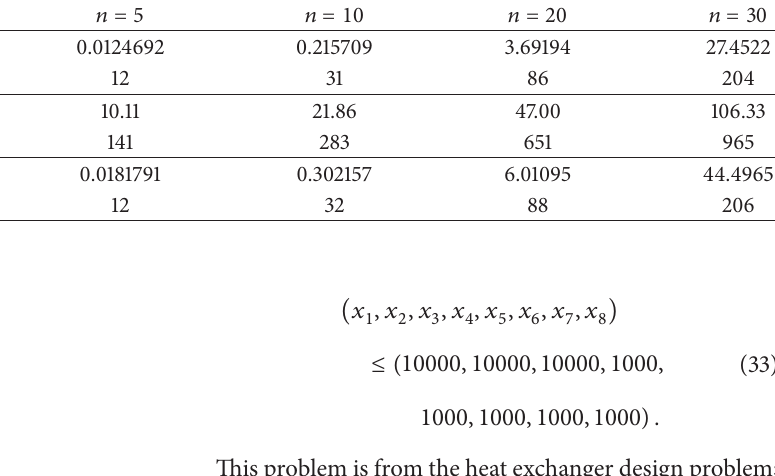
Table 3: Numerical comparisons with Refs. [16, 21] for Example